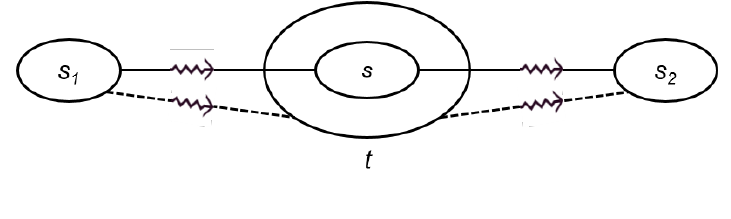
Figure 17. Transitions and